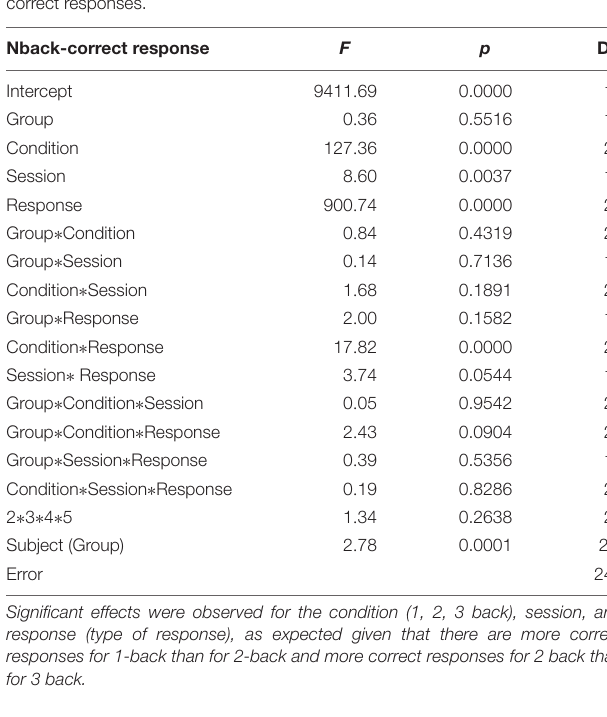
TABLE 1 | Statistical results of the GLM analysis for the number of correct responses.